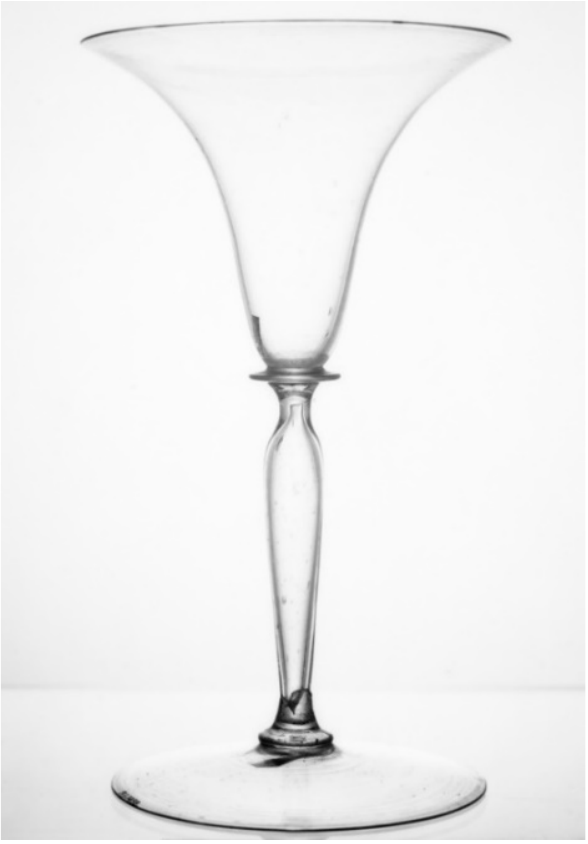
Figure 11. Venetian wineglass (Murano, 16th century